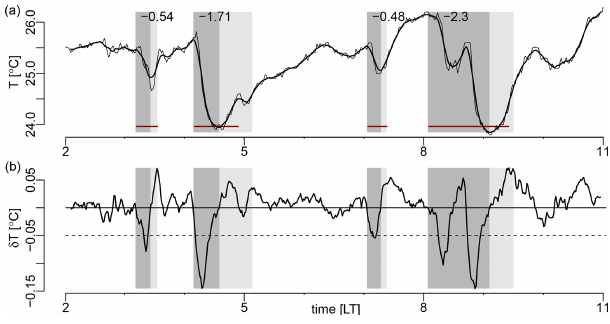
Figure 1. Illustration of the cold-pool detection algorithm. (a) 11min filtered T fil (thick line) and 1min raw surface temper- ature (thin line), and (bottom) filtered temperature difference δT along with the threshold of − 0.05K used (dashed). The detected cold-pool fronts and wakes are indicated in dark grey ( t max to t min ) and light grey ( t min to t end ), with the corresponding (cid:49)T indicated at the top. The dark red lines in (a) show the analysis periods used for computing the diagnostics (see Sect.